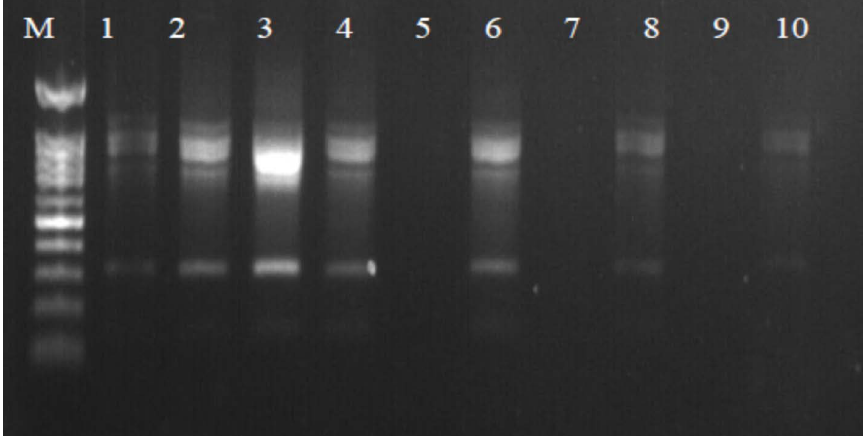
Fig. 6. Agarose gel electrophoresis of OPX-8 amplified product. The electrophoresis pattern of genomic DNA extracted from fenugreek ( Trigonella foenum-graecum ) leaf samples: 1, control; 2, Th-1; 3, Th-2; 4, AVG; 5, MeJA; 6, Th-1 + AVG; 7 Th-1 + MeJA; 8, Th-2 + AVG; 9, Th-2 + MeJA; 10, MeJA + AVG; M, DNA size marker. Electrophoresis conditions: 1% agarose concentration, 75 V, 20 mA for 120 min, stained with ethidium bromide.